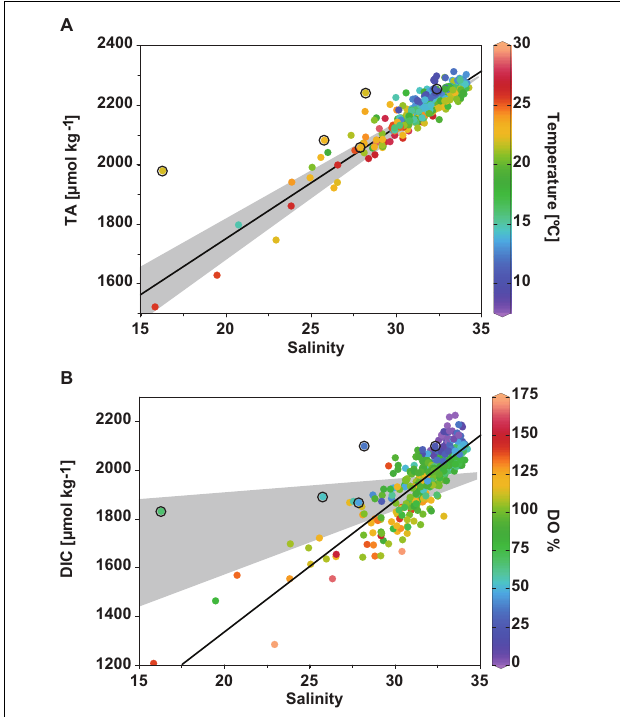
FIGURE 4 | Relationships between (A) TA and S, colored by T, (B) DIC and S, colored by DO%. Black lines represent the least square linear fits of each plot. Gray area shows the mixing of offshore water ( S = 34.82, TA = 2,293 µ mol kg − 1 , DIC = 1,960 ∼ 1,990 µ mol kg − 1 ) with river water ( S = 0, TA = 1,013 ± 156 µ mol kg − 1 , DIC = 1,047 ∼ 1,800 µ mol kg − 1 ). Circled data points represent the observations of the water samples collected in October